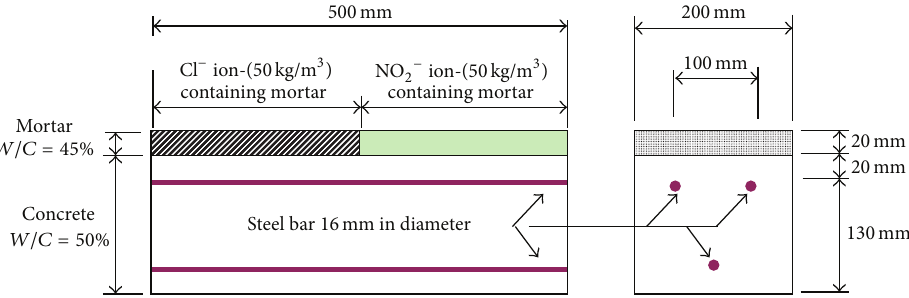
Figure 8: Concrete prisms for determining the penetration rate of NO 2− and Cl − ions from mortars to concrete.